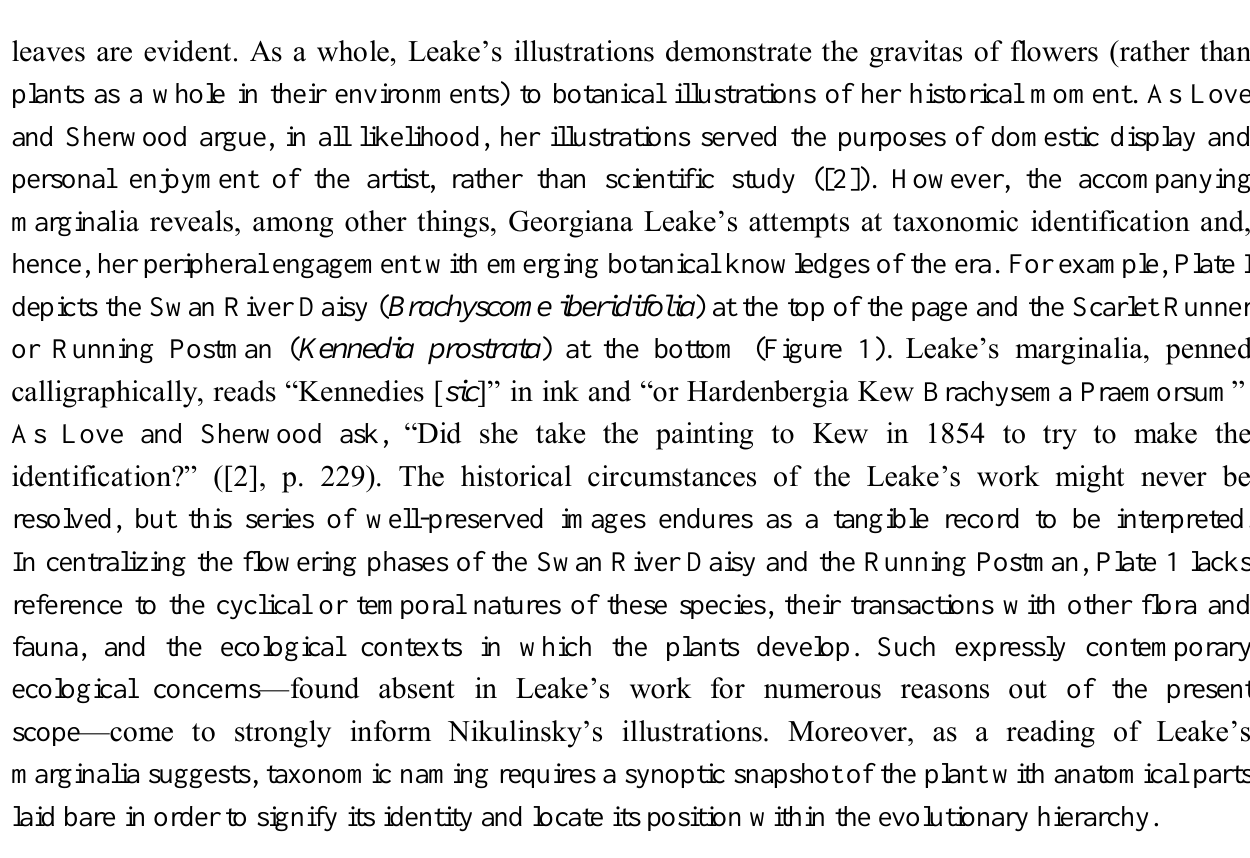
Figure 1 . Plate I of Georgiana Leake’s Wildflower Album with Swan River Daisy and Scarlet